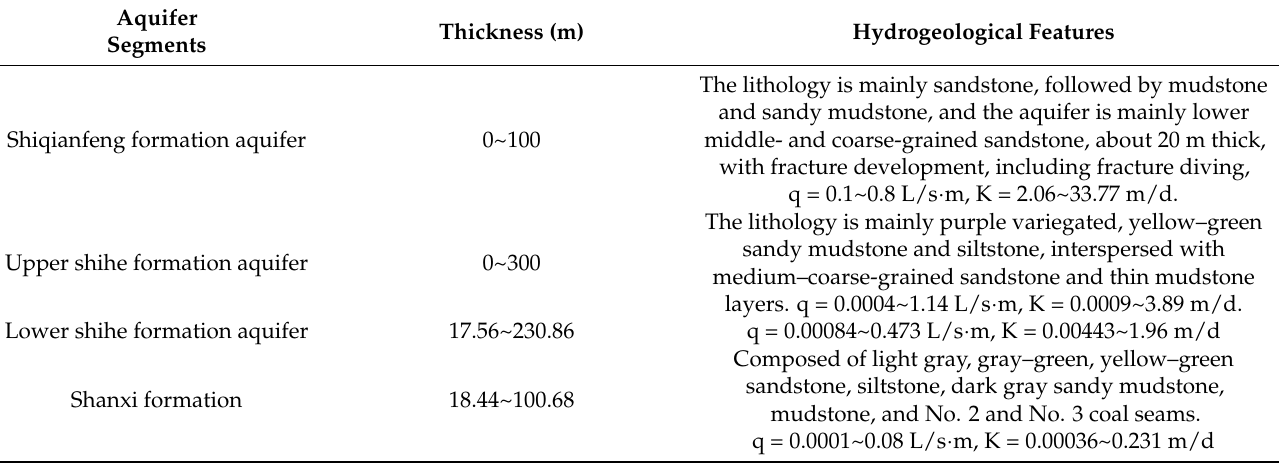
Table 2. Hydrogeological characteristics of Permian sandstone fractured